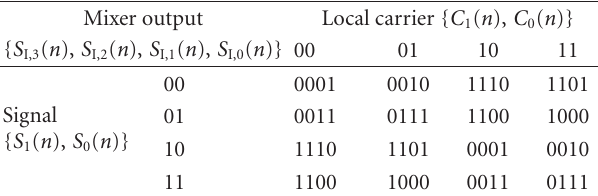
Table 3: Truth table of the carrier